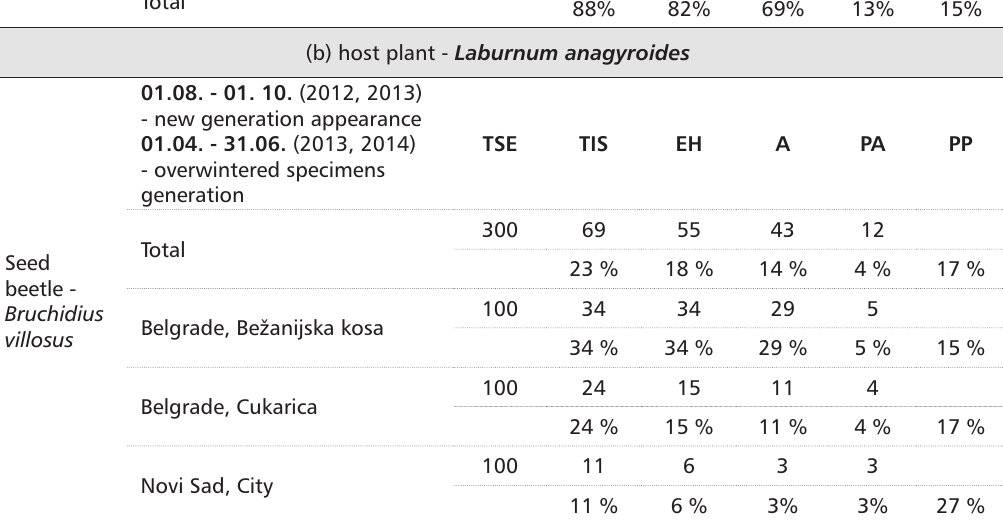
Table notes and legend: (a) Emergence of the seed beetle Bruchidius terrenus from seeds of Albizia julibrissin with emergence of beetle parasitoids (Eupelmid and Braconid) from B. terrenus . (b) Emergence of the seed beetle Bruchidius villosus from seeds of Laburnum anagyroides with emergence of its parasitoids (Pteromalid,Eupelmid, Eulophid and Braconid). TSE - total seeds examined; TIS - total infested seeds and percentage of infested seeds; EH - number of seeds with emergence holes; A - number of adults; PA - Number of parasitoids (pteromalid, eupelmid, eulophid); PP - Number of parasitoids (PA) divided with total infested seeds (TIS) (in percentage)